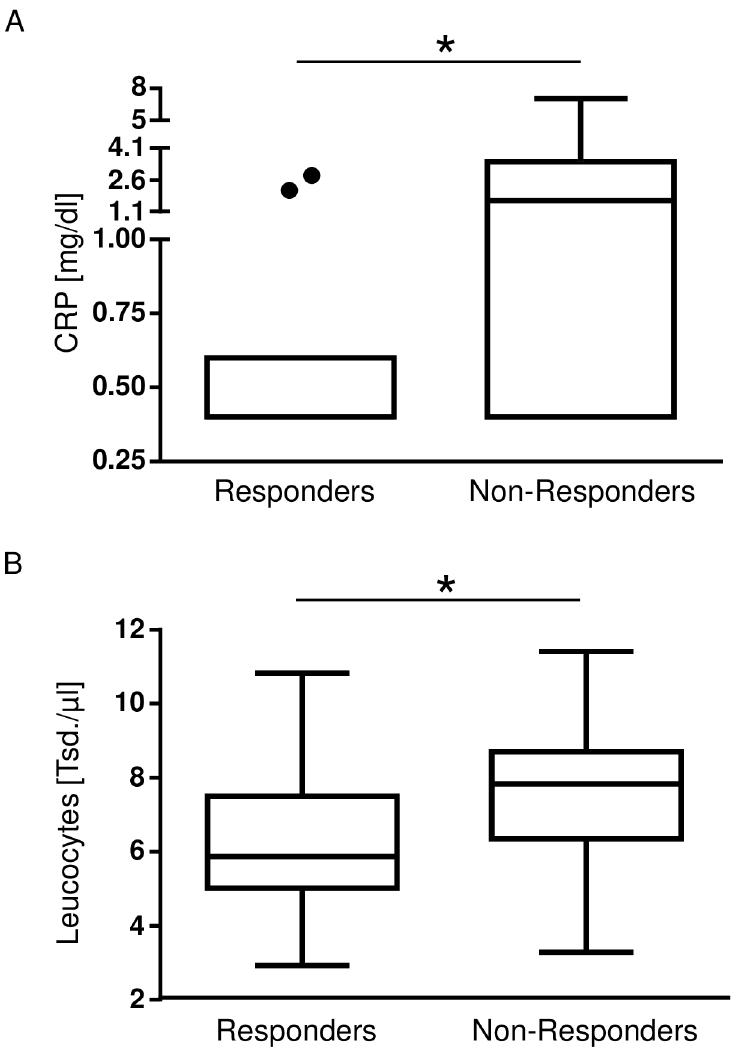
Fig 3. Comparison of the inflammatory parameters leukocytes and CRP in the groups of responders and non- responders. CRP levels and leukocytes as parameters of inflammation were compared between the groups of responders and non-responders. (A) CRP levels were higher in the group of non-responders (responders: 0.4mg/dl [0.4, 0.5], n = 11, vs. non-responders: 1.6mg/dl [0.4, 2.5], n = 13, (cid:3) p = 0.04). (B) Leucocytes were higher in the group of non-responders, too (responders: 5.87 (cid:3) 10 3 /μl [5.2, 7.1], n = 19, vs. non-responders: 7.84 (cid:3) 10 3 /μl [6.39, 8.6], n = 21, (cid:3) p =